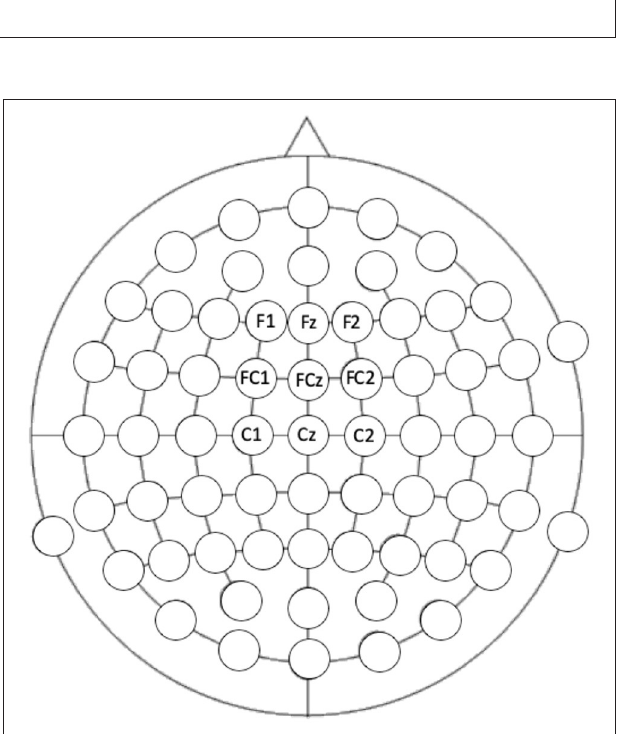
FIGURE 2 | Electrode locations that were extracted for analysis. Location of the electrode was included in the analysis: frontal, frontocentral, and central rows compared to the left, central, and right